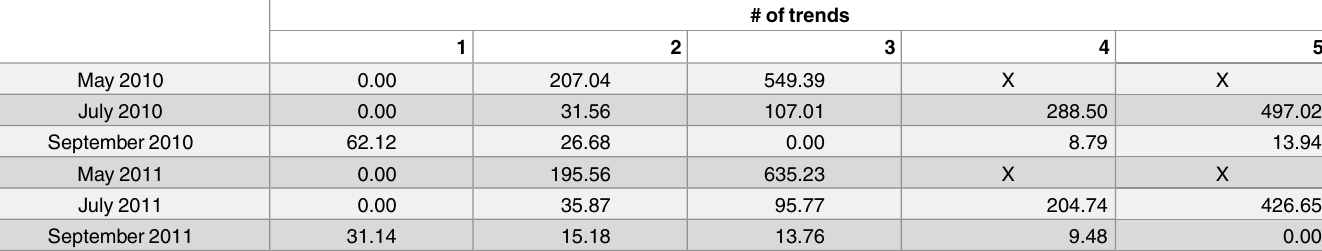
Table 4. Summaryof the Δ AICc values for each numberof trendsand capturegroup withoutcovariates. X denotesmodelsthat were not